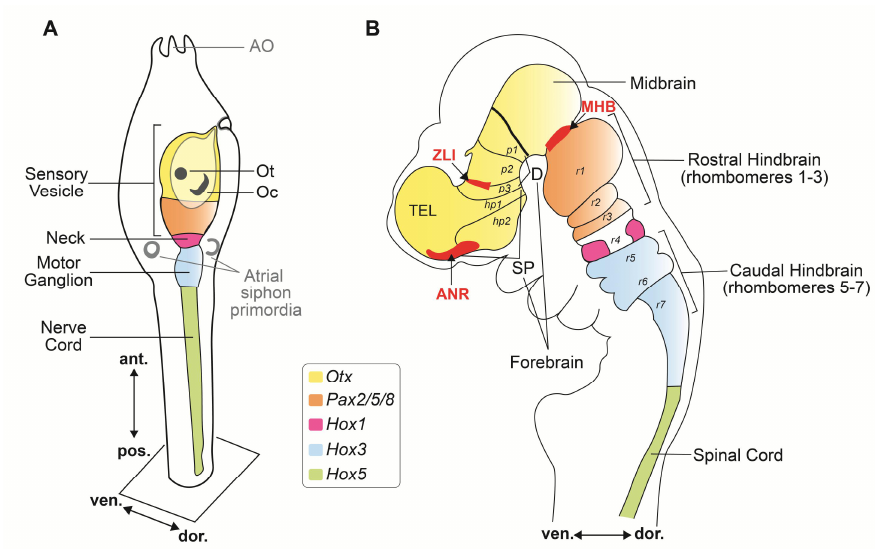
Figure 1. General organization and presumed homologous regions of the central nervous system (CNS) in ascidian larvae and vertebrate embryos. Drawings of a Ciona larva ( A ), ~18 h after fertilization and a mouse embryo ( B ), ~9 days old (stage E9.5). The developing nervous systems of these divergent chordates exhibit a comparable anterior-posterior sequential expression of the genes Otx (yellow), Pax2 / 5 / 8 (orange), Hox1 (magenta), Hox3 (blue), and Hox5 (green). Abbreviations: ANR, anterior neural ridge; ant., anterior; AO, adhesive organ; D, diencephalon; dor., dorsal; hp, hypothalamic prosomere; MHB, mid-hindbrain boundary; Oc, ocellus; Ot, otolith; p, prosomere; pos., posterior; r, rhombomere; SP, secondary prosencephalon; TEL, telencephalon; ven., ventral; ZLI, zona limitans intrathalamica . Adapted from [10,17,55].